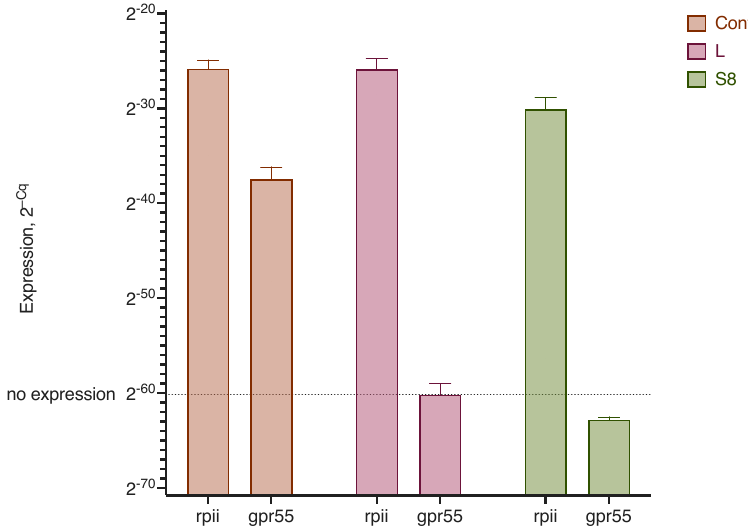
Figure 13. Cell transfection efficiency with lipoplexes prepared from LNPs with GM3 gangliosides and siRNA against the GPR55 receptor gene. Control, native MDA-MB-231 cells; LF, siRNA transfection with lipofectamine; S8, siRNA–LNPs S8 lipoplex transfection (1.7% GM3; see Table 1). Genes: rpii, POLR2A housekeeping gene; gpr55, GPR55 receptor gene. Incubation time was 72 h. RT-qPCR data and expression results are presented as values of 2 to the degree minus the number of the quantification cycle, n = 2.